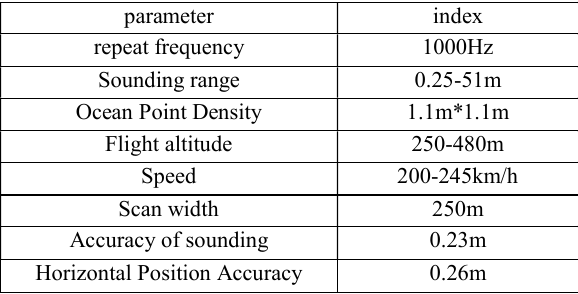
Table 1. Technical performance indicators of airborne laser sounding system recently developed in China (He et